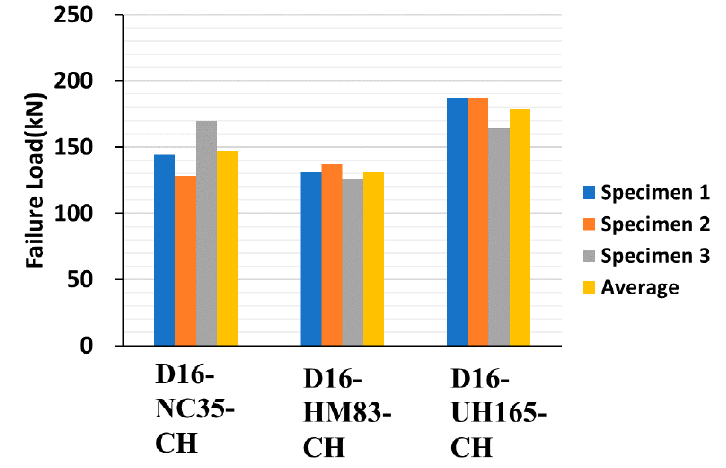
Figure 16. Pull-out test results of 16 mm GFRP rebars (normal concrete, mortar, UHPC).